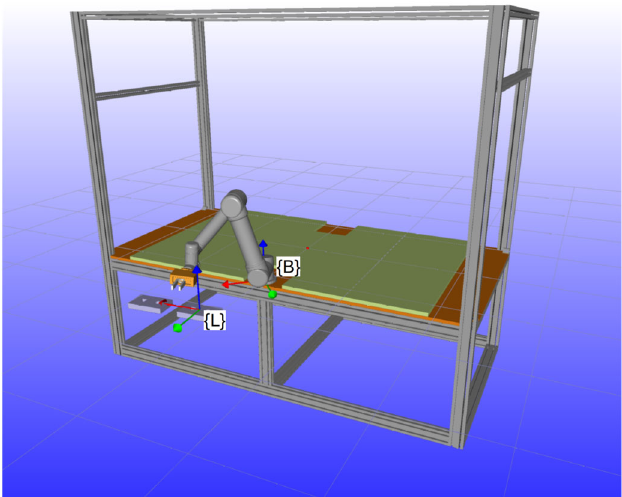
Figure 7. The RobWorkStudio environment used to visualize the robotic setup and control the robot trajectory during the task execution. The plugin used for robot control is visible to the right. The task location frames are shown in the visualization.